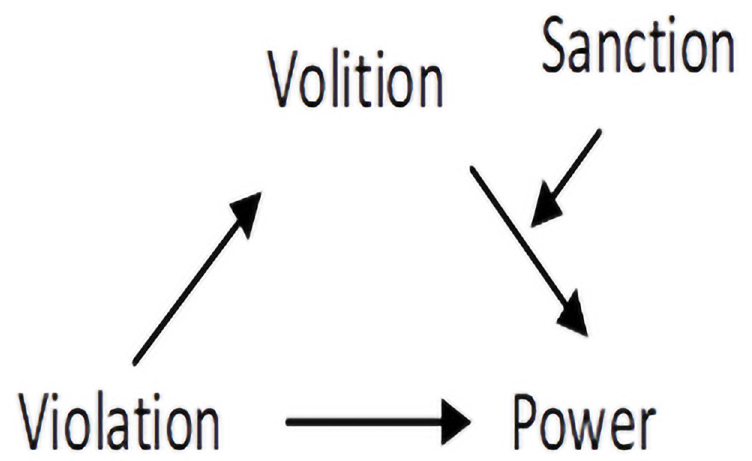
Fig 1. Conceptual model of the proposed moderating effect of